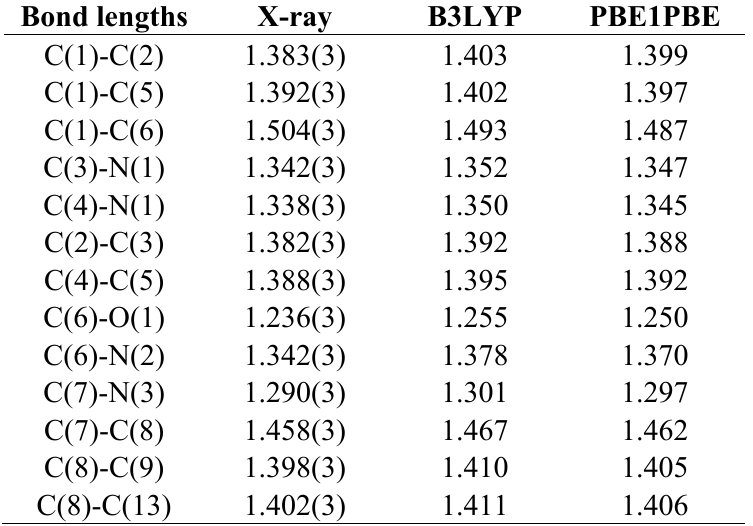
Table 3. Comparison of calculated bond length (Å) for the compound 1